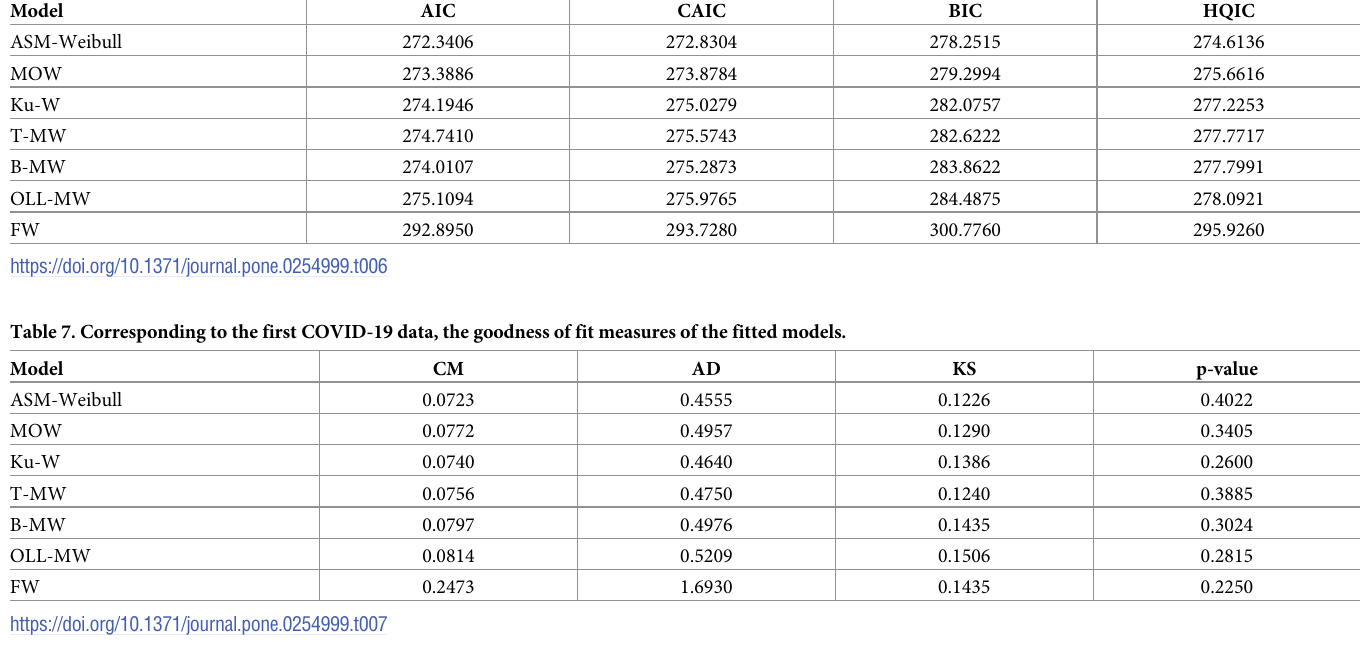
Table 6. Corresponding to the first COVID-19 data, the discrimination measures of the fitted models. Model